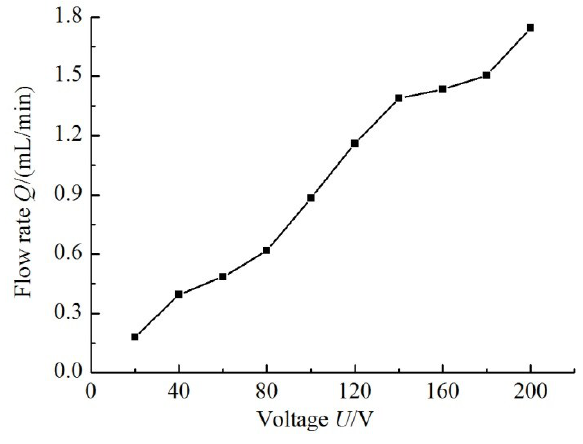
Figure 13. Simulation flow rate with various driving voltage inputs at 6 Hz.